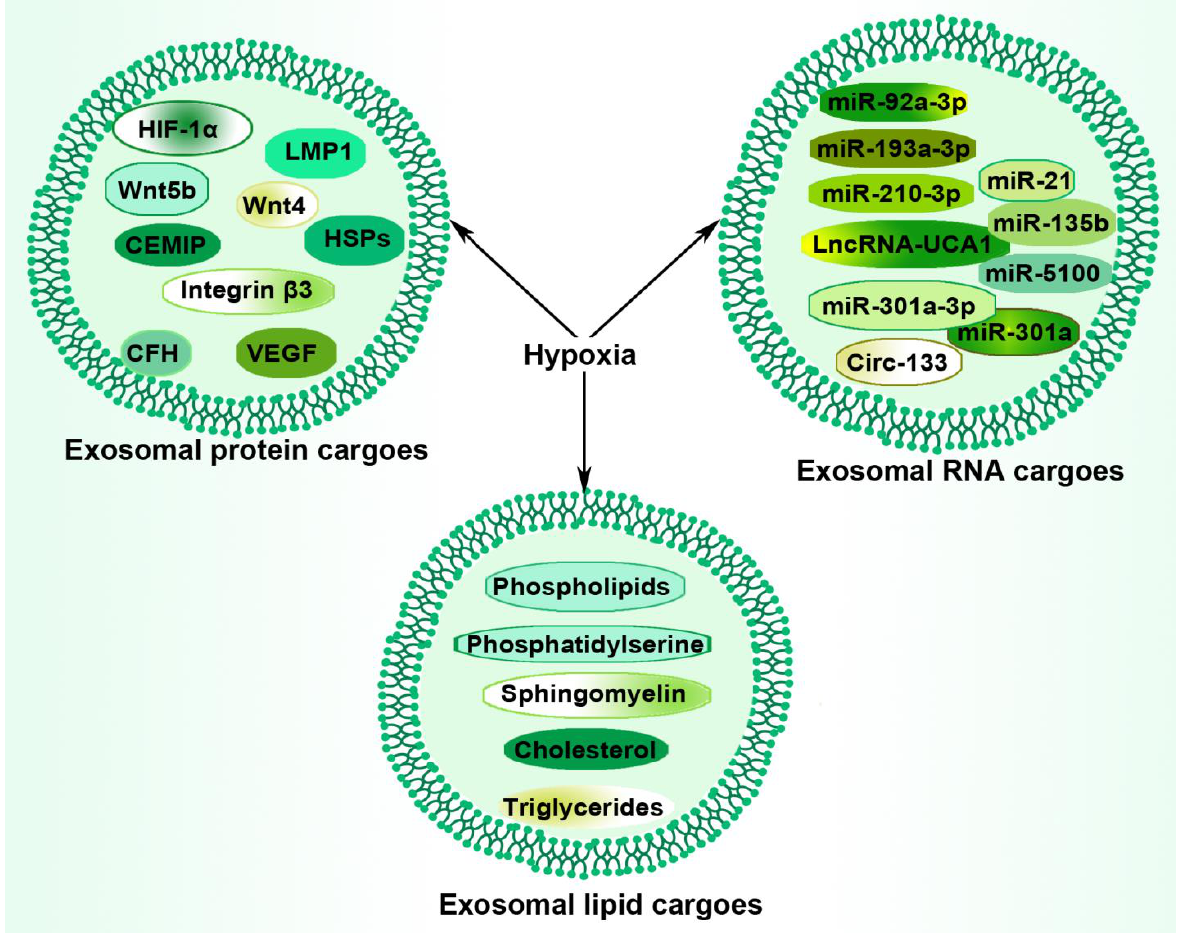
Figure 2. Hypoxia-induced packaging of exosomal cargos. Exosomes consist of three primary components: nucleic acids, proteins, and lipids. Hypoxia within the TME regulates the loading of these regulatory particles for subsequent transfer between cells, enhancing tumor promotion. Thus, these cargos could provide potential targets in the application of hypoxia tumor-derived exosomes in cancer therapeutics and diagnosis.